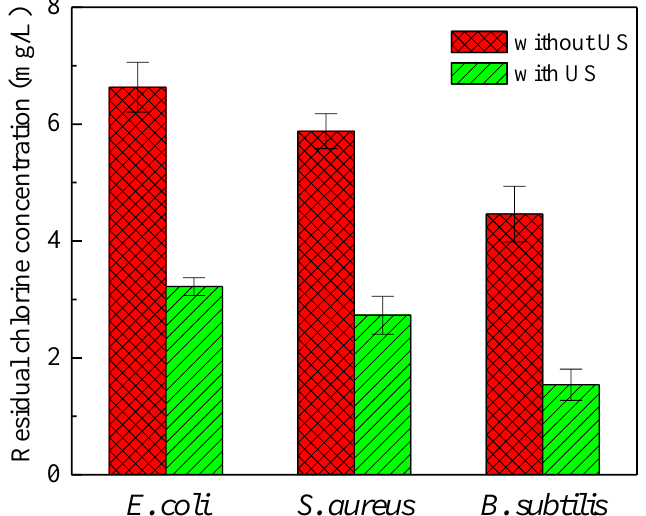
Figure 6. Residual chlorine concentration without or with 17 + 33 kHz dual-frequency US pretreatment at 8 mg/L NaClO (30 min chlorination time). Error bars correspond to standard error of three replicate experiments.